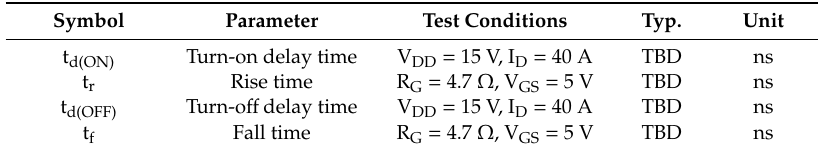
Table A2. Switching on / o ff (inductive load) STD95N3L (LH6).